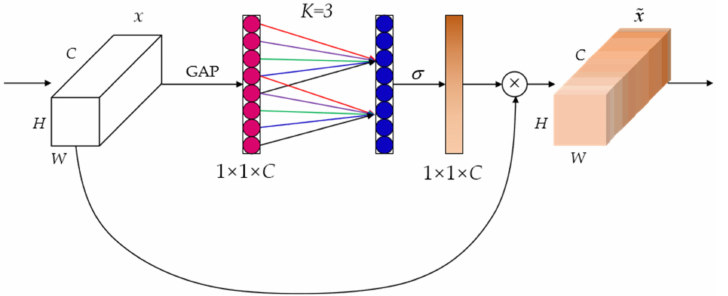
Figure 5. ECA structure